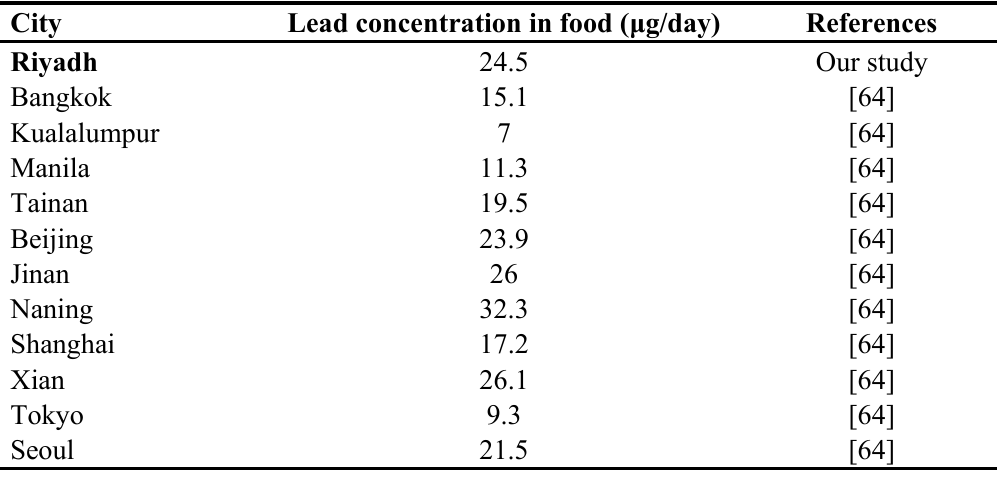
Table 4. Comparison of the estimated Pb intake of population in various